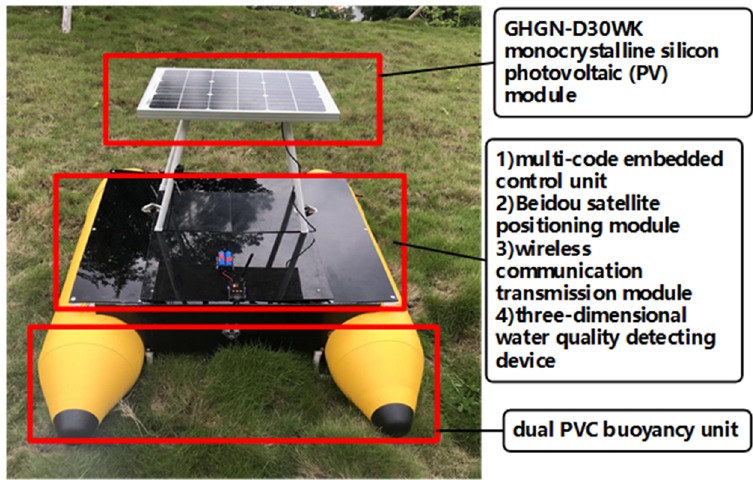
Figure 3. Structural distribution map of the USV. PVC, polyvinyl chloride.